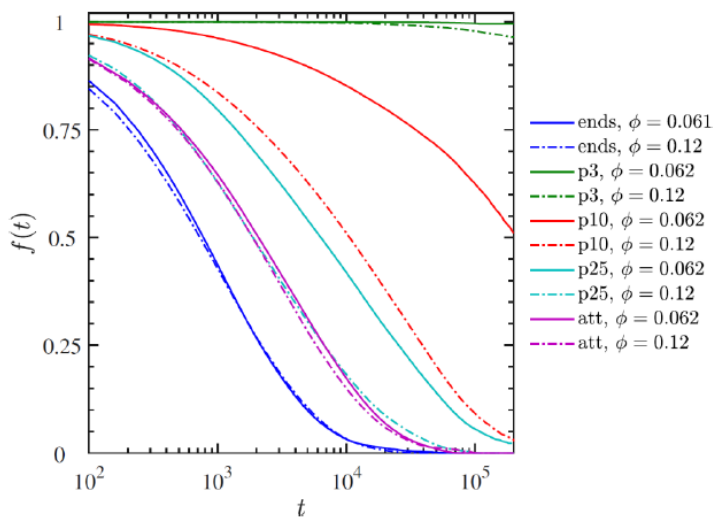
Figure 19. Survival probability f ( t ) versus reduced time t of ionic crosslinks for different nanoparticle volume fractions, polymer charge density, and localization of charges. Reprinted with permission from Mugemana et al.